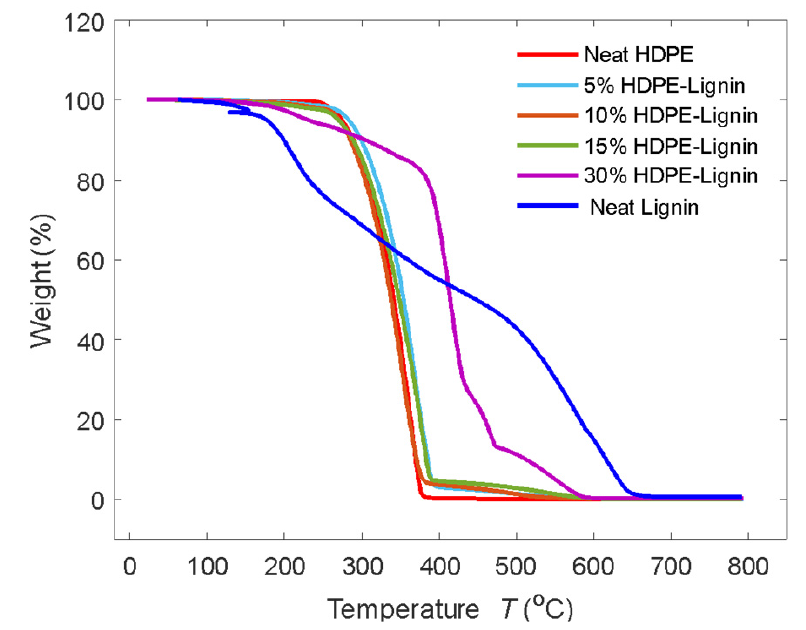
Figure 5. TGA curves for different blends of HDPE and lignin.